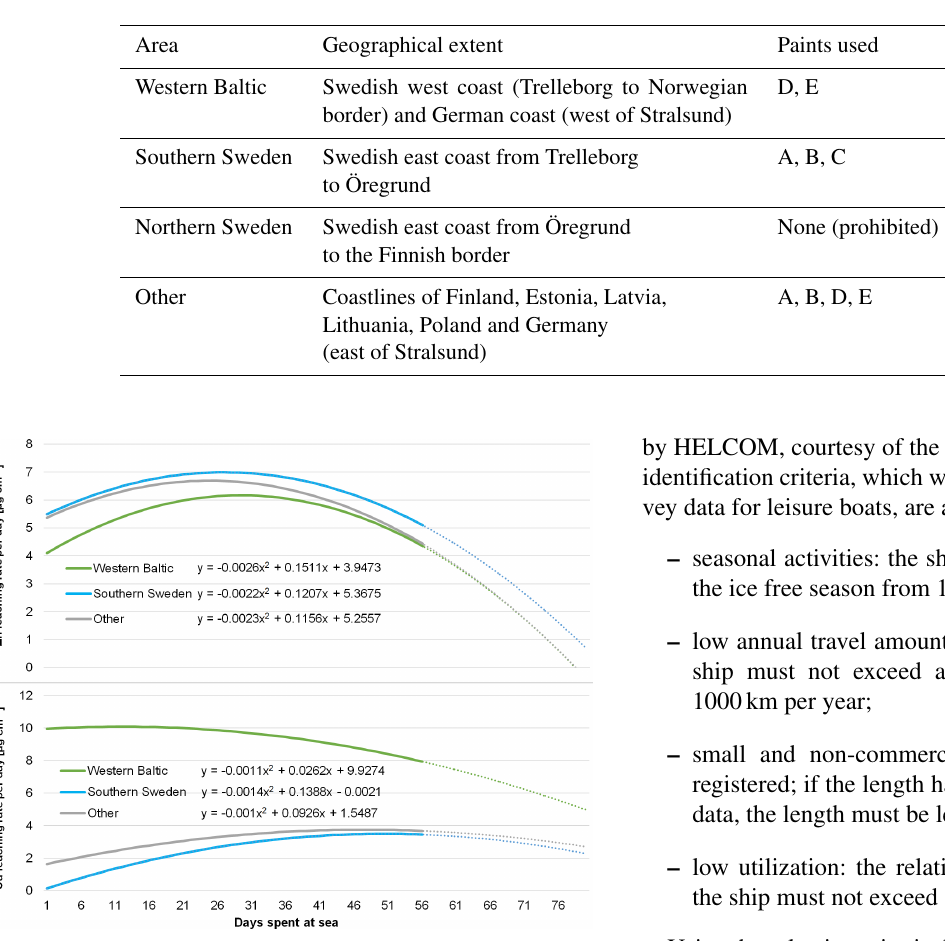
Table 4. Geographical areas and their assumed antifouling paint use. For each area, the release rates of the paints used were averaged; for example, the release rate for southern Sweden is based on average values from paints A, B and C. The release rate calculations were based on paint-specific release rates from Lagerström et al. (2018) where these were derived from exposure at salinity 5 and 14. The salinity assumption for each area is also listed here.